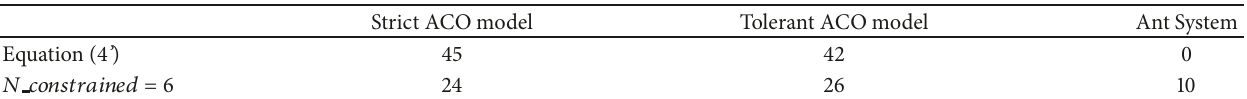
Table 3: The number of trials of the shortest tour of each model by replacing a certain equation. Eil 51 was used for these analyses. One hundred trials are conducted.